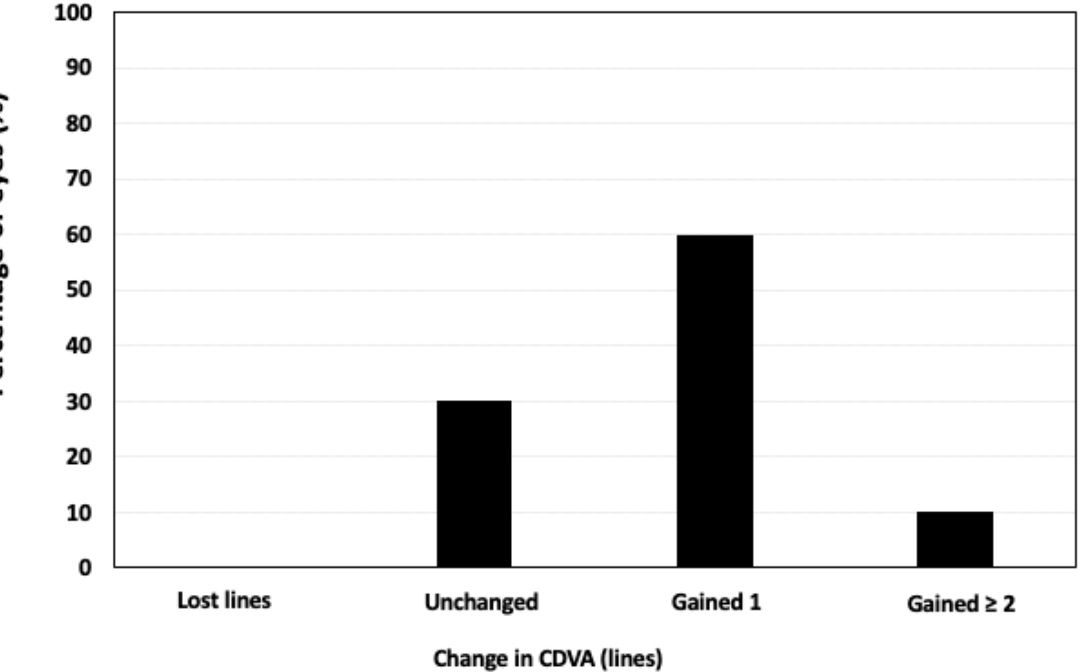
Figure 2. Variation in CDVA 6 months after Femto-LASIK. The SE decreased from a preoperative value of − 2.34 ± 2.03 to − 0.99 ± 0.86 at six months after Femto-LASIK ( p = 0.01). The refractive cylinder reduced from − 3.88 ± 1.00 D preoperatively to − 0.93 ± 0.39 six months after Femto-LASIK ( p < 0.0001). Figure 3A,B shows the correlation analysis between the targeted versus achieved (predictability) of the astigmatism component (J0 and J45) six months after Femto-LASIK. A total of 7 eyes (70%) and 10 eyes (100%) were within ±0.50 D of the target refraction for J0 (r 2 = 0.94) and J45 (r 2 = 0.98), respectively. In all cases, the astigmatism components (J0 and J45) significantly moved towards the graph’s origin (0, 0) after Femto-LASIK (Figure 3C). In all cases, the preoperative refractive cylinder was ≥ 2.50 D (range − 2.50 to − 5.00). Conversely, postoper- atively, the refractive cylinder was ≤ 1.50 D in all eyes (range − 0.50 to − 1.50 D) (Figure 3C, dot line circle). Seven eyes (70%) had a postoperative refractive cylinder ≤− 1.0 D (Figure 3C black line circle). A bioptic surgery was planned in cases 2 and 4 (Femto-LASIK for cylinder correction, and then three months later, a spherical Implantable Collamer Lens (ICL; STAAR Surgical Inc., Monrovia, CA, USA) was implanted to correct the associated spherical component).